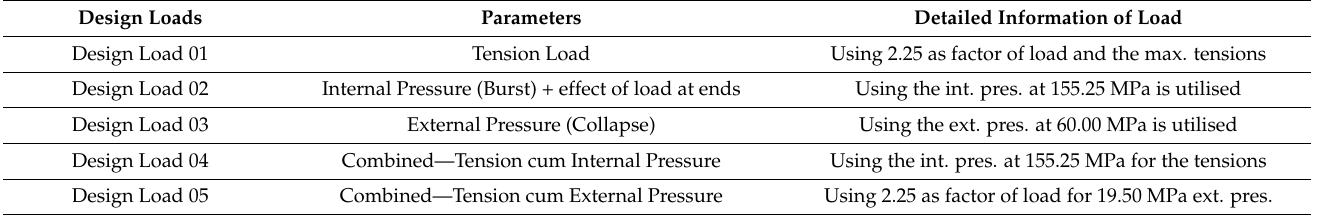
Table 5. The design loadings for modelling the composite riser.